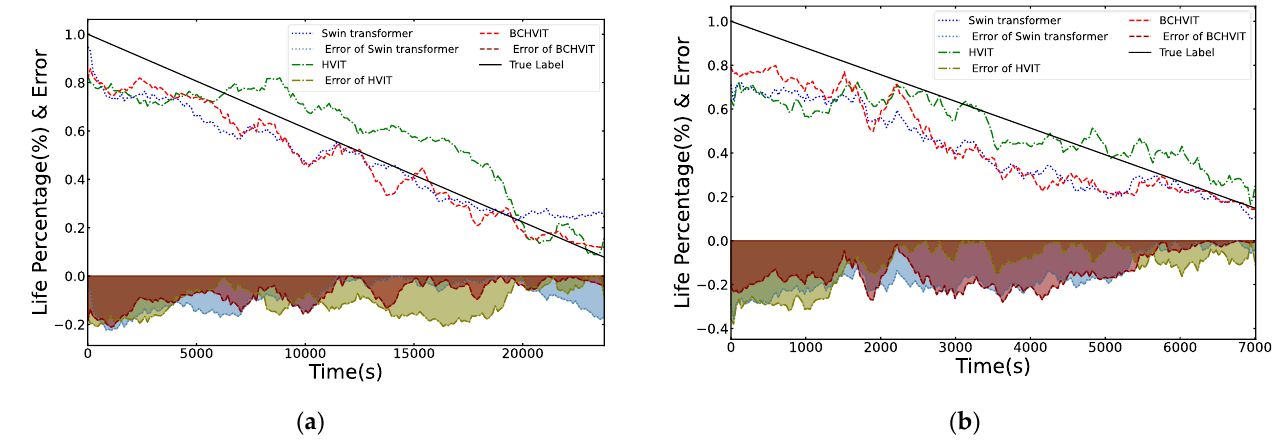
Figure 10. RUL prediction result of ablation experiment in Test 1: ( a ) Bearing 1-3; ( b ) Bearing 2-6.